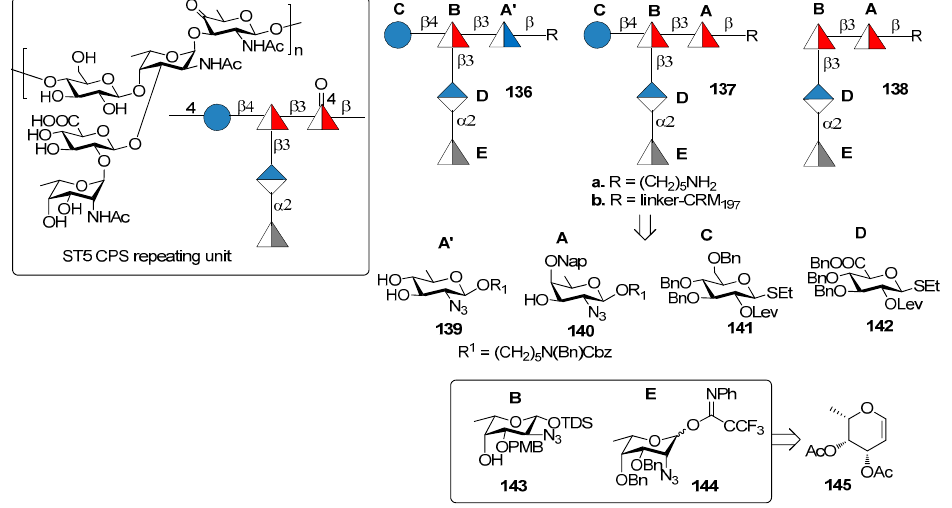
Figure 15. Repeating unit of ST5 CPS and synthetic glycan fragments reported in [89].